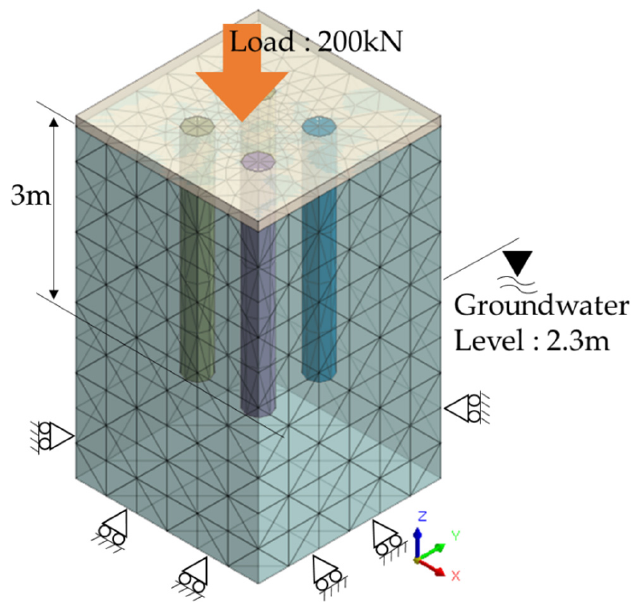
Figure 4. Boundary conditions of FEM analysis